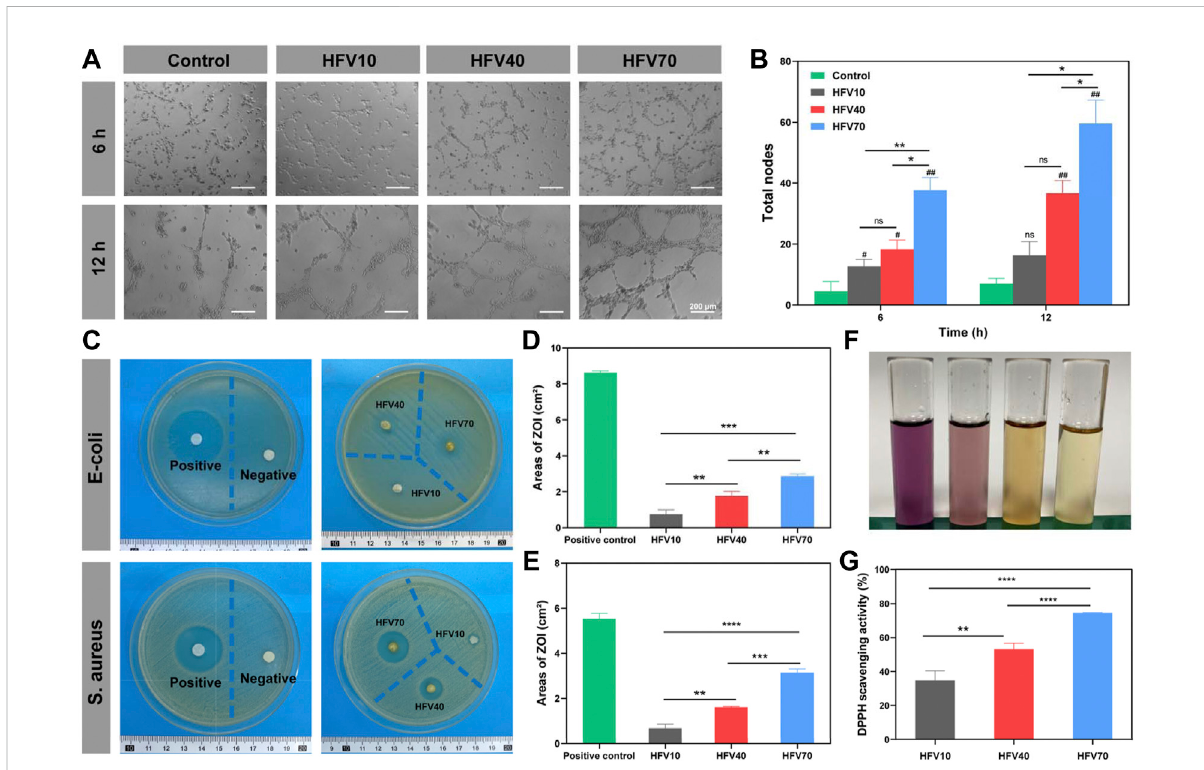
FIGURE 5 Evaluation of angiogenesis and antibacterial and antioxidant properties of HFVs in vitro . (A) Images of HUVEC tube formation. (B) Quanti fi ed results of the total tube nodes of HUVEC tube formation. (C) Inhibition zone images of E. coli and S. aureus on agar plates after being treated with samples. (D) Areas of ZOI against E. coli by the HFVs. (E) Areasof ZOI against S. aureus by HFVs. (F) Macro photographs of theDPPH scavenging test. (G) DPPH scavenging rates. * p < 0.05; ** p < 0.01; *** p < 0.001; **** p < 0.0001, in comparison with the control